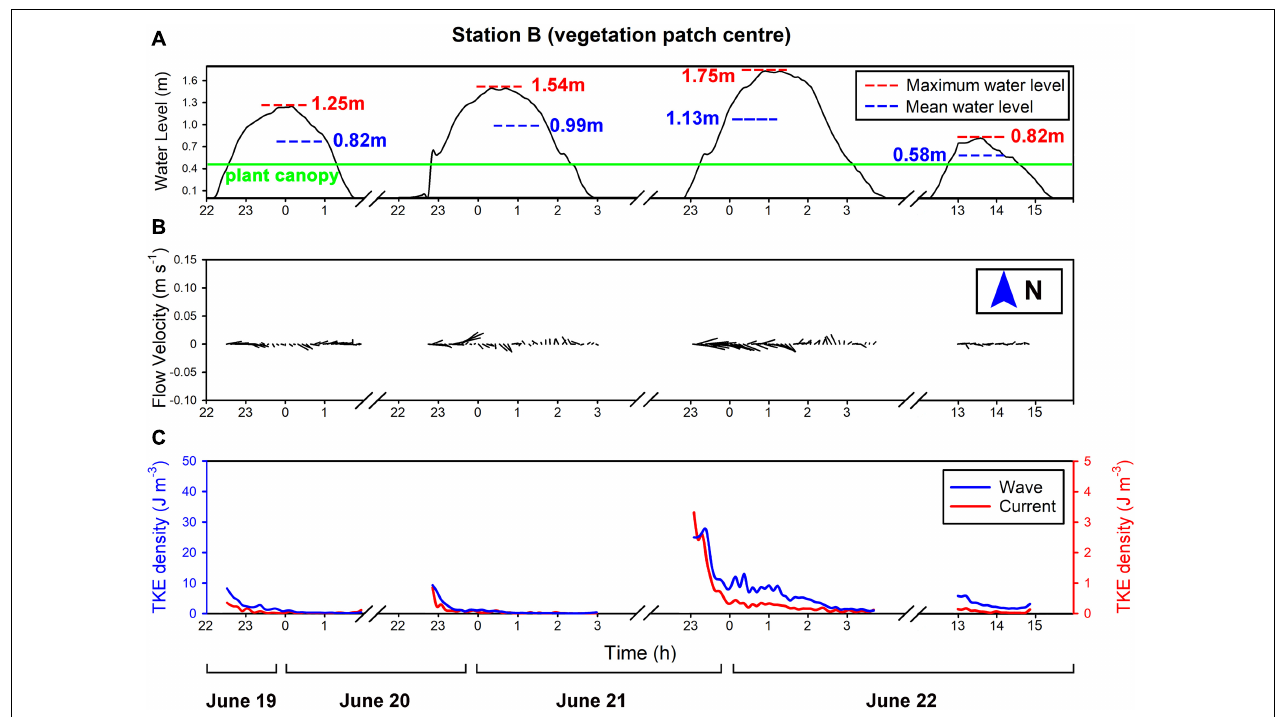
FIGURE 6 | Four tidal cycles were observed and recorded at Station B (vegetation patch center) from June 19 to 22: (A) water level variations of each tidal cycle (the maximum water level and the average water level are given separately); (B) the flow velocity variations of each tidal cycle (the length of the flow vector segment represents the velocity magnitude); (C) the TKE density variations of the currents and waves in each tide cycle. TABLE 2 | The consistency index statistics of the calculation results of the phase method and the pressure inversion method compared with the measurement results of the wave loggers (1 = strong agreement, 0 = no agreement). Station A(mudflat) A(mudflat) B(vegetation)